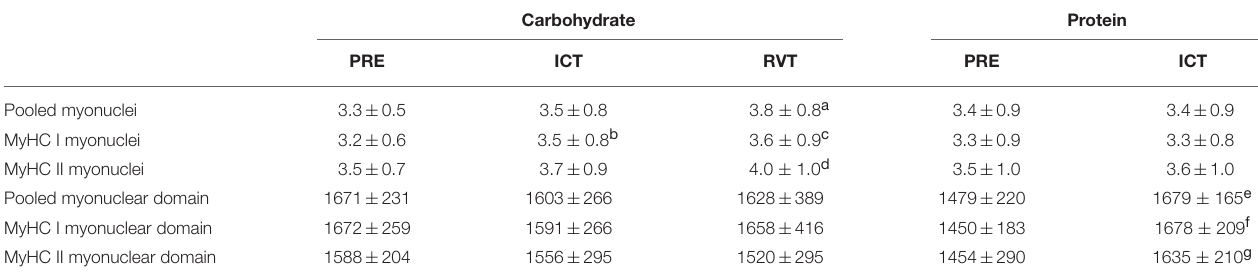
TABLE 3 | Myonuclear density (Myonuclei/Fiber), and myonuclear domain ( µ m 2